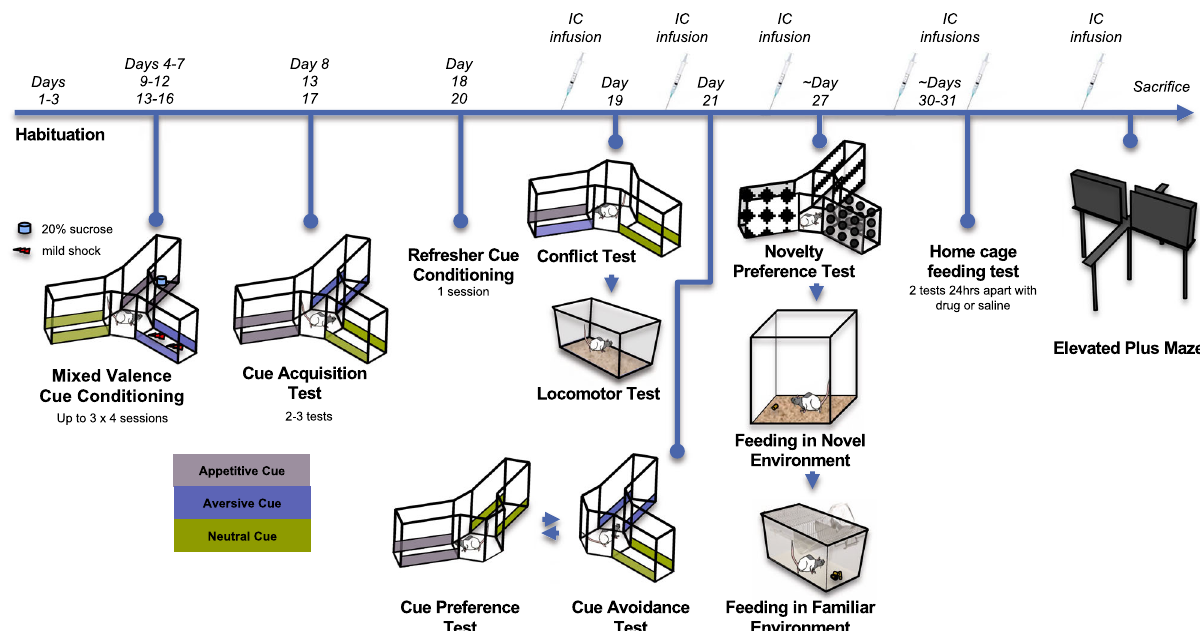
Fig. 1 Timeline of experiments. Following surgery, animals were trained in the mixed valence Y-maze task fi rst. Following a successful cue acquisition test, animals received intracranial microinfusions of CNO (1 mM, depicted as IC infusion) and were administered a con fl ict test and locomotor test. After a refresher conditioning session, animals were infused again, and then administered the appetitive and aversive preference tests. Next, animals were given ~5 days of free feeding, and then food restricted for a novelty detection test, novel environment suppressed feeding (NESF) and the familiar environment suppressed feeding test (FESF), prior to which CNO was microinfused. Following these tests, the animals were given free access to food for 24 h, and were then food restricted again prior to the two free feeding tests, which occurred on successive days. Finally, animals received a fi nal infusion of either CNO or saline, were administered the elevated plus maze, and sacri fi ced thereafter for brain